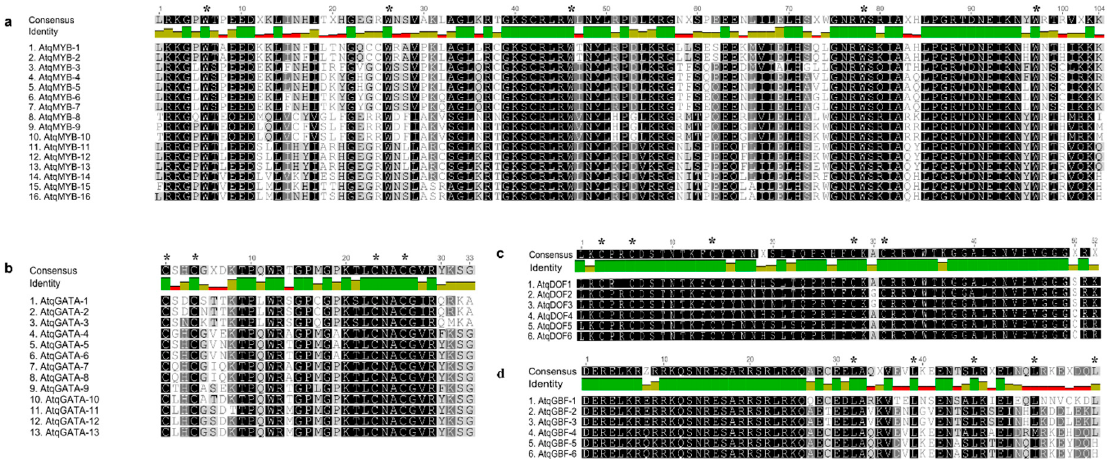
Figure 5. Comparison of amino acid motifs of the MYB, GATA, DOF and GBF transcription factors in A. tequilana . ( a ) R2R3 motif of the MYB family, ( b , c ) zinc finger motif of the GATA and DOF family and ( d ) the basic leucine zipper (bZIP) of the GBF family. Asterisks (*) indicate tryptophan (W), cysteine (C) and leucine (L) conserved residues that are crucial for the MYB, GATA/DOF and GBF function, respectively. Graphs above alignments indicate highly conserved residues shown as dark